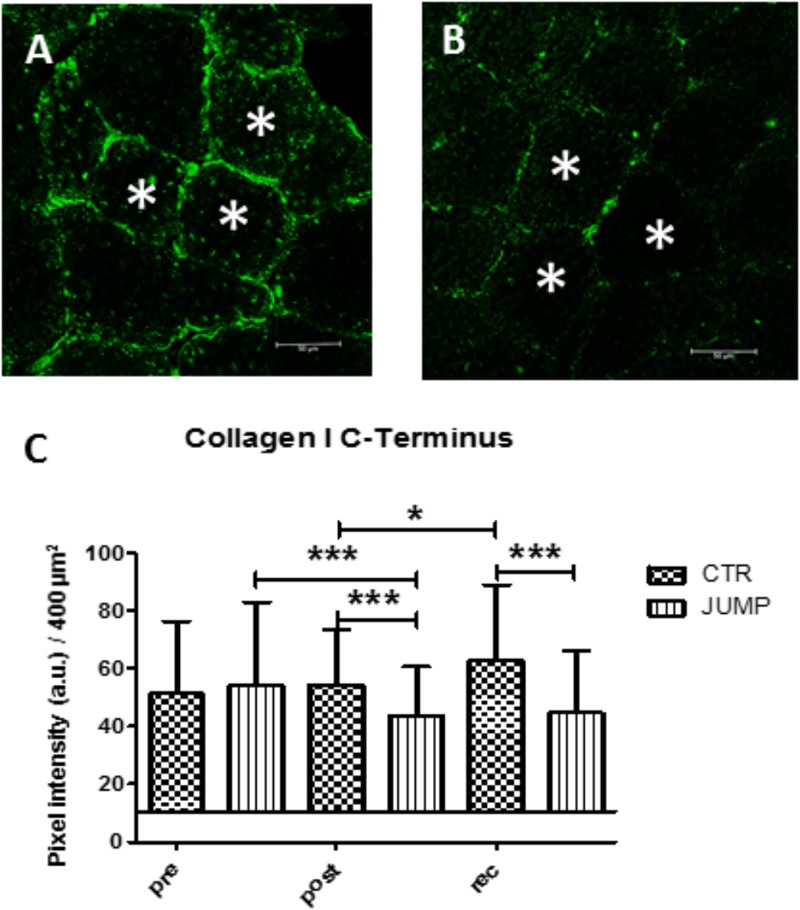
Immunohistochemistry of collagen-1 network adaptation in RSL soleus biopsy. (A), CTR group (post-BR HDT+59) shows increased collagen-1 immunoreactivity at peri- and endomysial tissue around cross-section myofibers, (B), JUMP group (post-BR HDT+59) shows reduced collagen-1 immunoreactivity, (C) Quantification by area pixel-intensity determination (200 × 200 μm2) in each group at bed rest start (Pre), end (Post) and recovery (rec). ∗p < 0.05, ∗∗∗p < 0.001 (n = 100 myofibers/cryosection). a.u., arbitrary units, Bar = 50 μm.